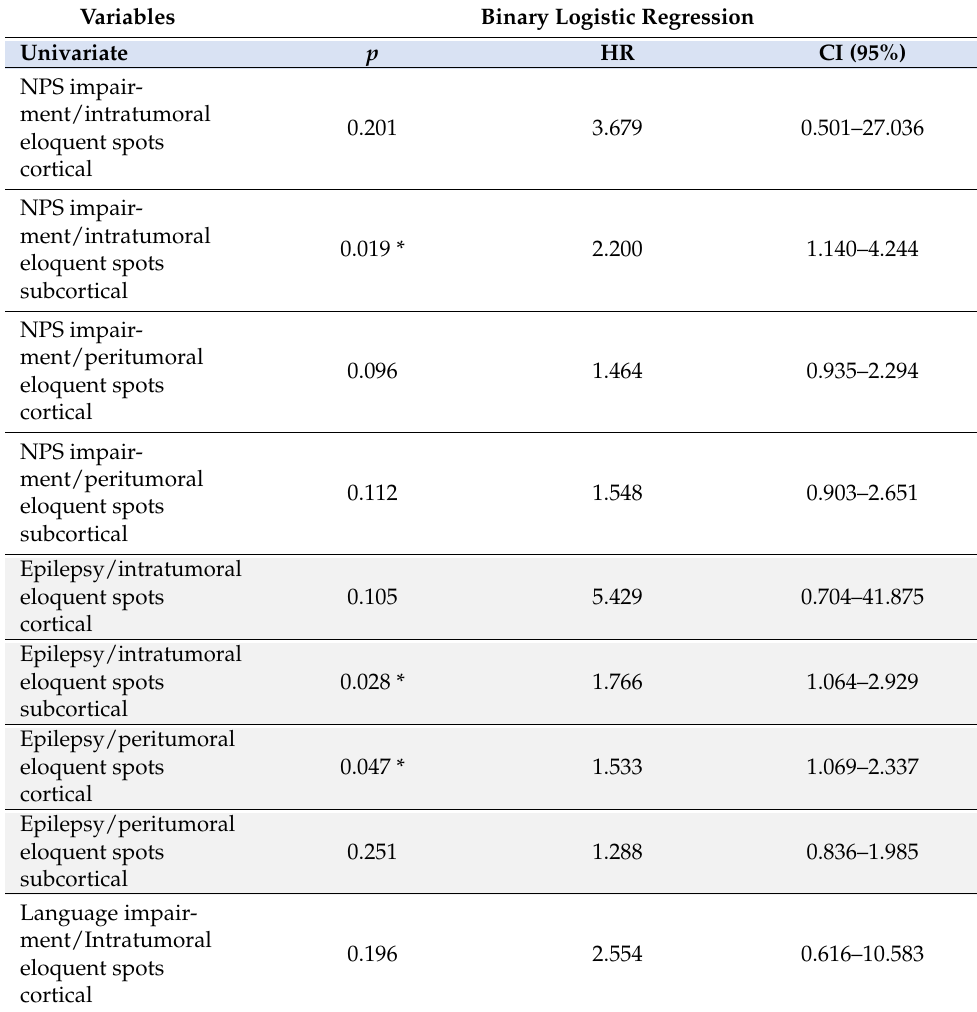
Table 5. Summary of the logistic regression analysis. Univariate model with NPS impairment, epilepsy and language impairment as dependent variables correlated with the number of intraoper- ative eloquent spots and the different infiltrated BG voxels. The lower part shows the result from the multivariate analysis with Eloquent tumors as dependent variable and all the demographic, radiological and clinical variables analyzed as predictor factors. * Correlation is significant with p value < 0.05. HR, Hazard Risk; CI, confidence